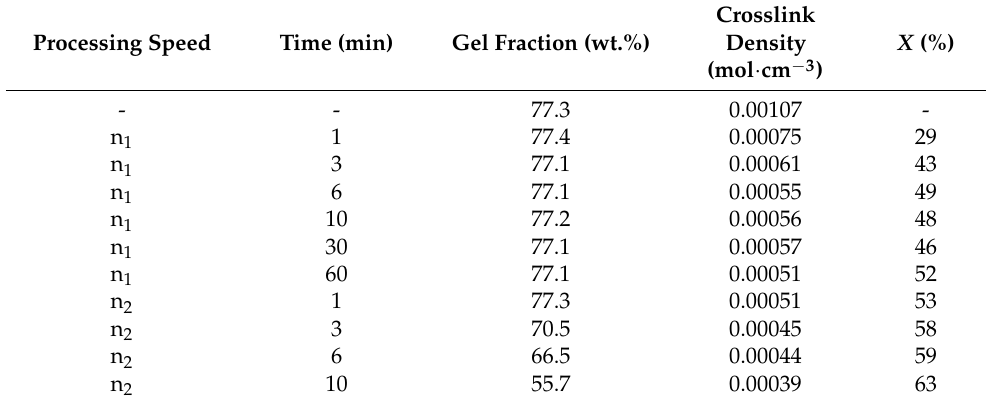
Table 2. Gel fraction ( ξ ), crosslink density ( ν ) and mechanochemical efficiency, X .